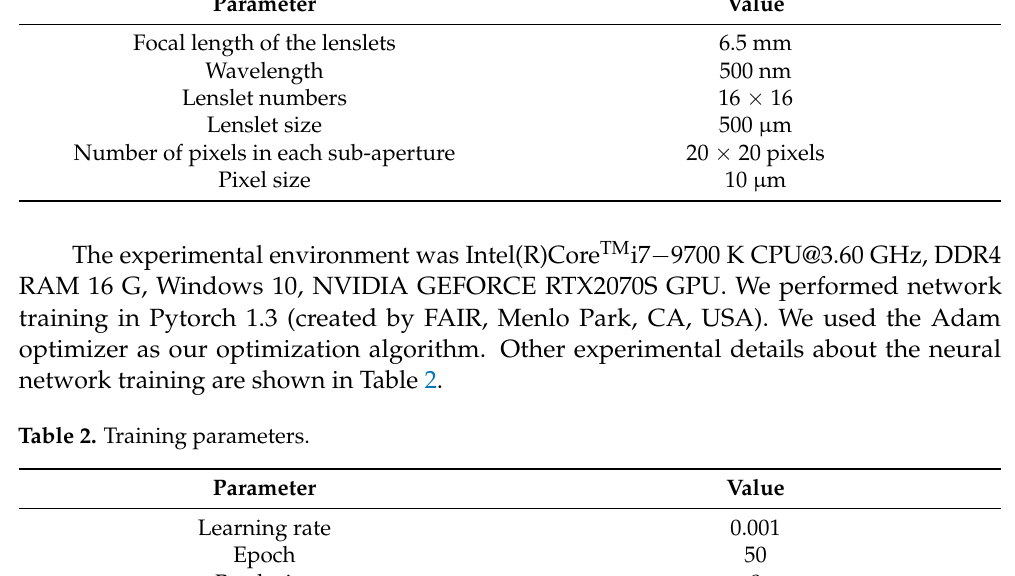
Table 1. The key parameters of the simulation. Parameter Value Focal length of the lenslets Wavelength Lenslet numbers 16 × 16 Lenslet size 500 µ m Number of pixels in each sub-aperture